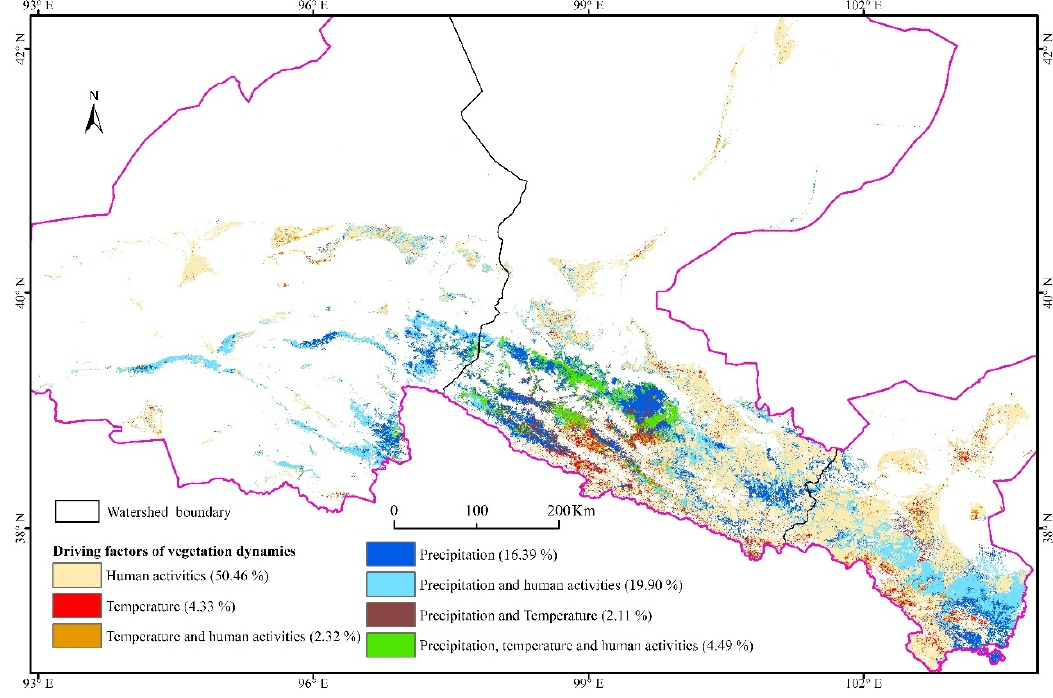
Figure 9. The results of driving factors analysis in the Hexi region based on the new framework proposed. Percentages in the legend were the proportion of vegetation changes caused by the each driving factors to the total vegetation changes.